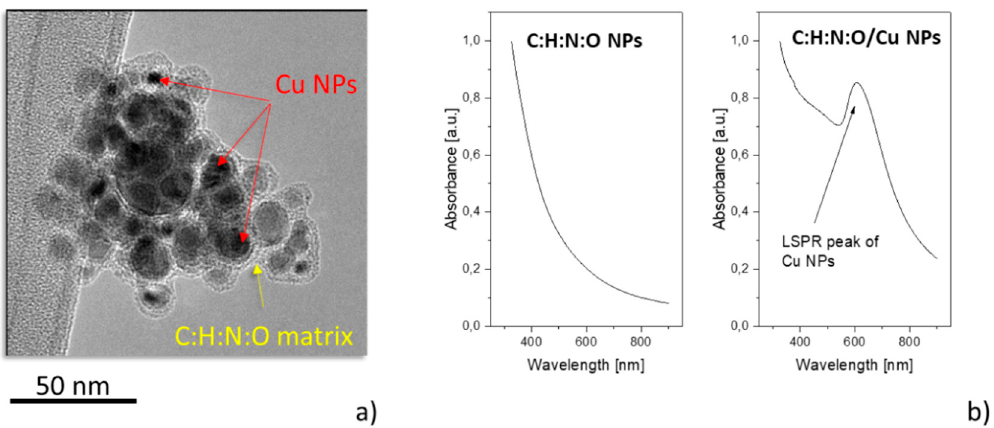
Figure 5. ( a ) Transmission electron microscopy (TEM) image of multi-core@shell Cu/C:H:N:O NPs produced when the composite target was used. ( b ) UV-Vis spectra of C:H:N:O NPs and